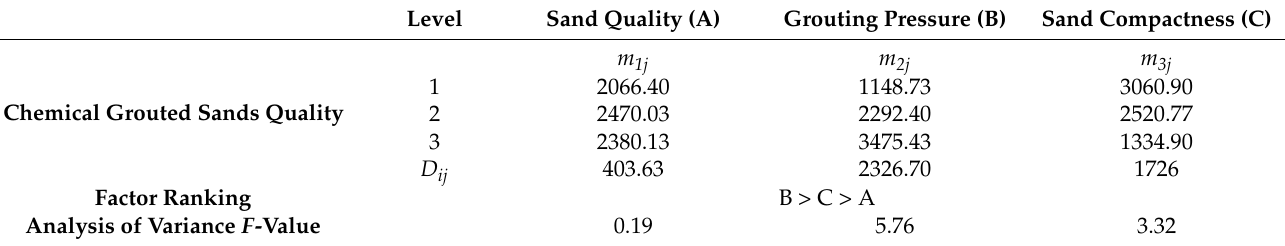
Table 7. Analysis table for the orthogonal test of chemical grouted sands mass.